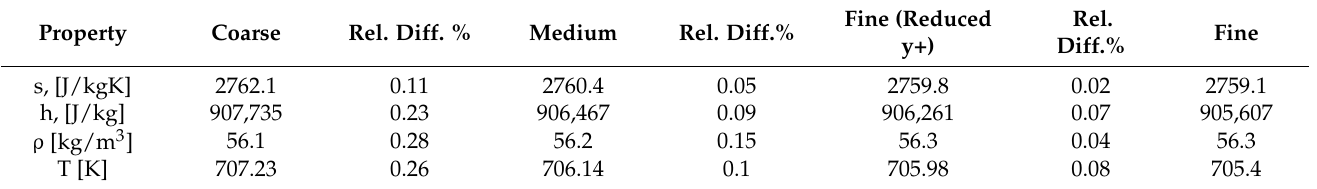
Table 3. Grid dependency study. Results are shown for the properties at the rotor discharge. The relative differences presented in the table are compared to the results obtained with the fine grid. Property Coarse Rel. Diff.